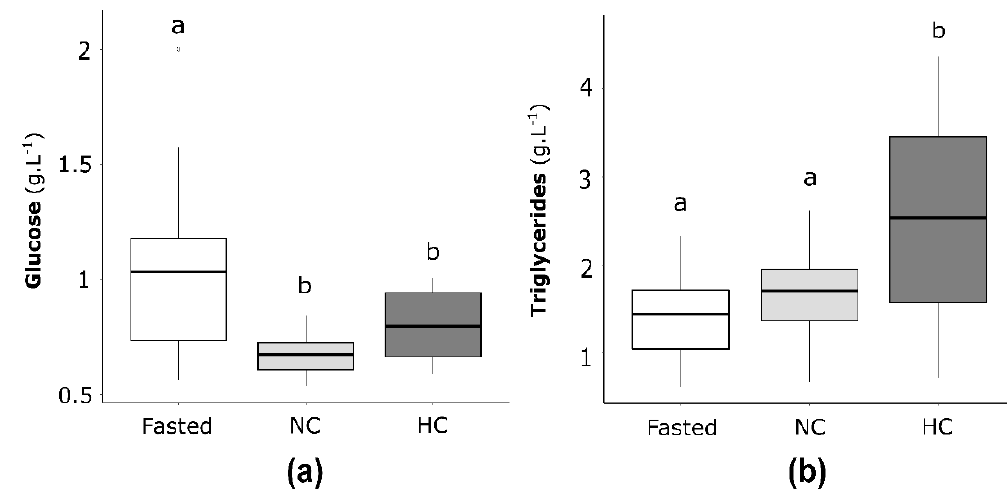
Figure 4 . ( a ) Plasma glucose and ( b ) triglycerides concentrations of mature male rainbow trout fasted for 15 days (Fasted, white), fed with the NC diet (non-carbohydrate diet, grey) and fed with the HC diet (high-carbohydrate diet, dark grey). Data ( n = 15 fish per condition) were analysed with either one-way ANOVA when the conditions of application were respected, or the Kruskal-Wallis test, followed by a post hoc Tukey’s test in case of significant differences ( p < 0.05, indicated with different letters).